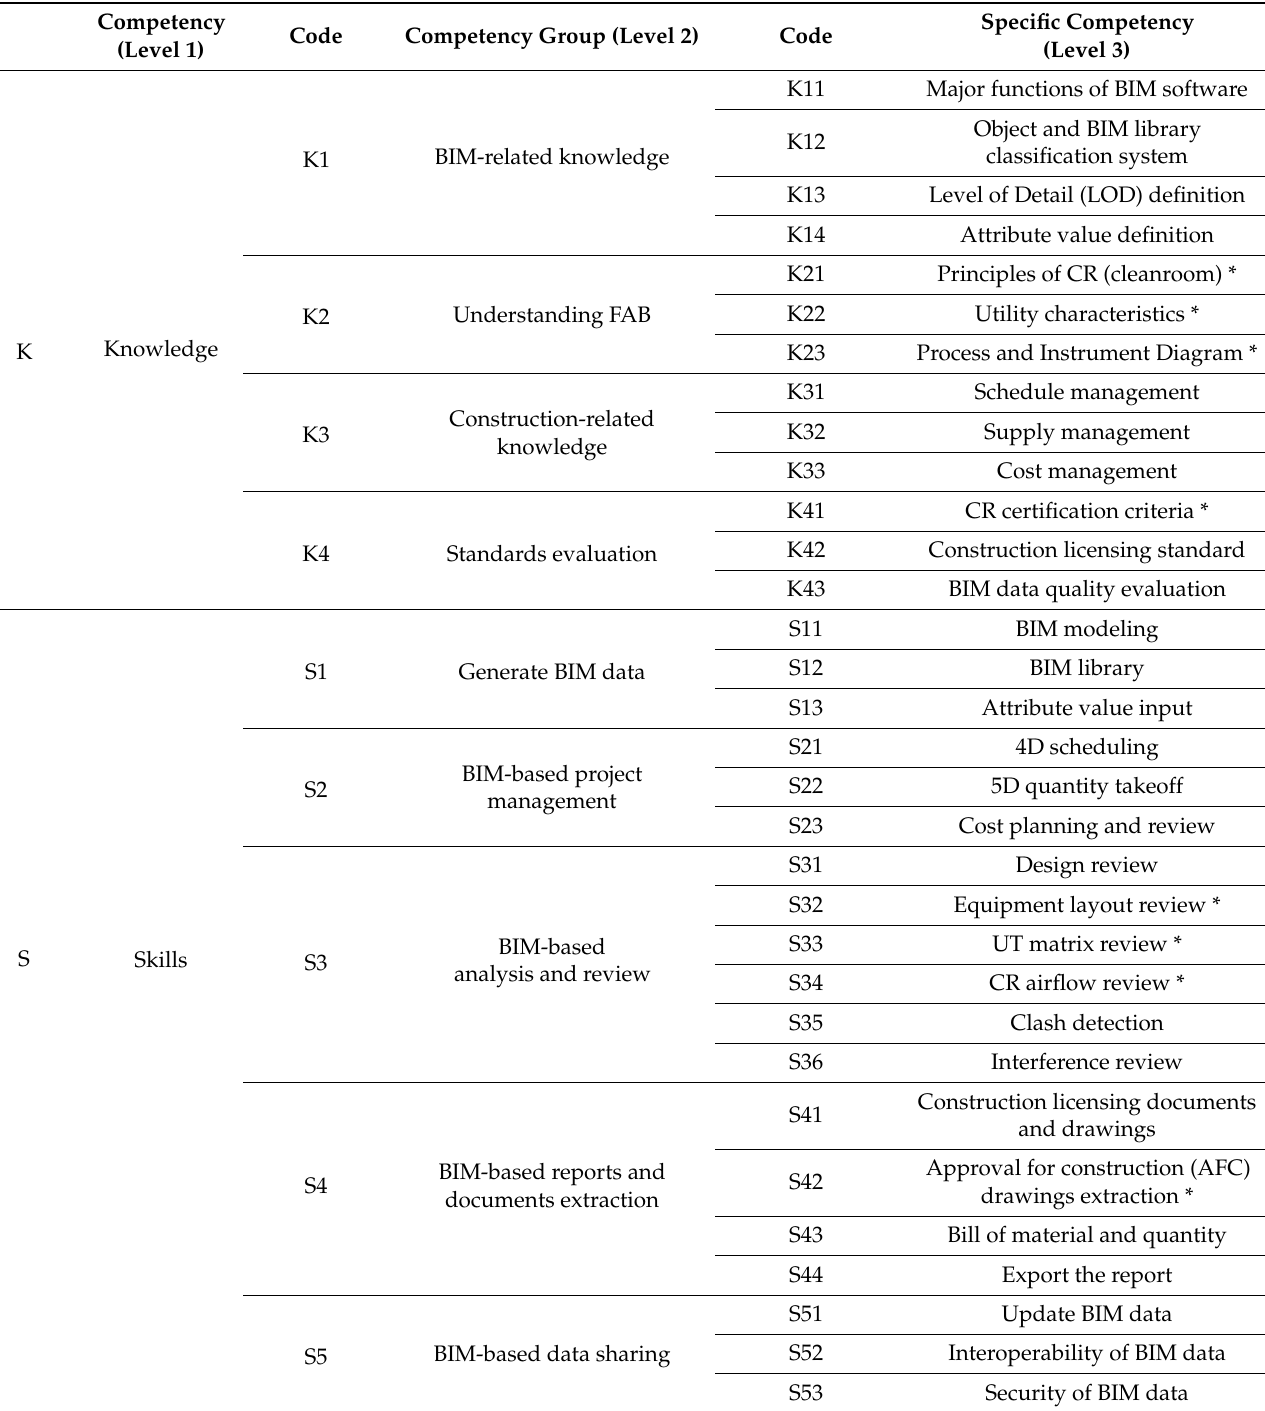
Table 2. FAB-BIM